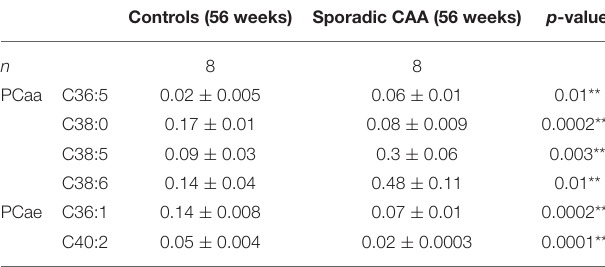
TABLE 1 | Plasma levels of selected lipids altered in CAA mice. Controls (56 weeks) Sporadic CAA (56 weeks) p -value